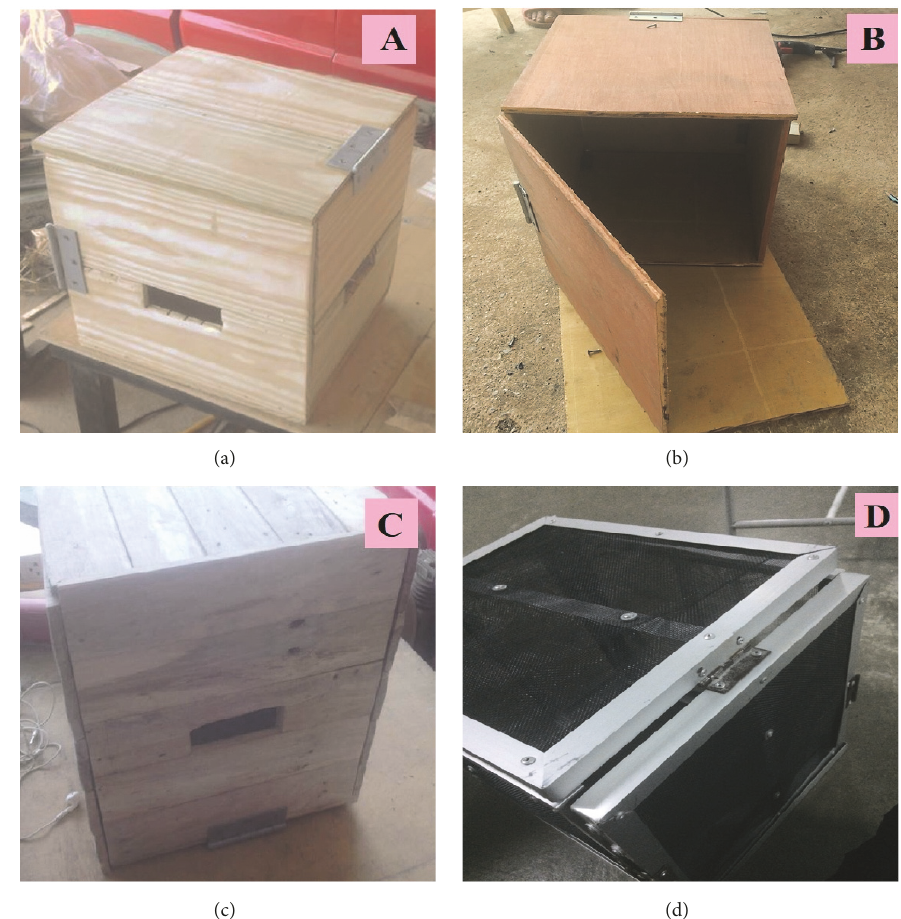
Figure 1: Design of the mosquito trapping boxes tested in Step 1 of the research and development phase. (a) Wooden trapping box constructed from Pinus kesiya wood; (b) wooden trapping box constructed from Dipterocarpus alatus wood; (c) wooden trapping box constructed from Tectona grandis wood; (d) control trapping box constructed from aluminum and black plastic